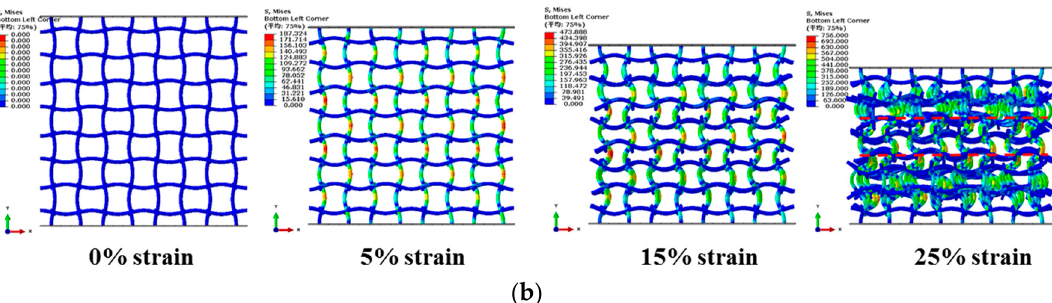
Figure 7. Front view of collapse modes of the NPR CCF1 under quasi-static uniaxial compressions in the y direction: ( a ) experiment; ( b ) numerical simulation (until 25% strain).